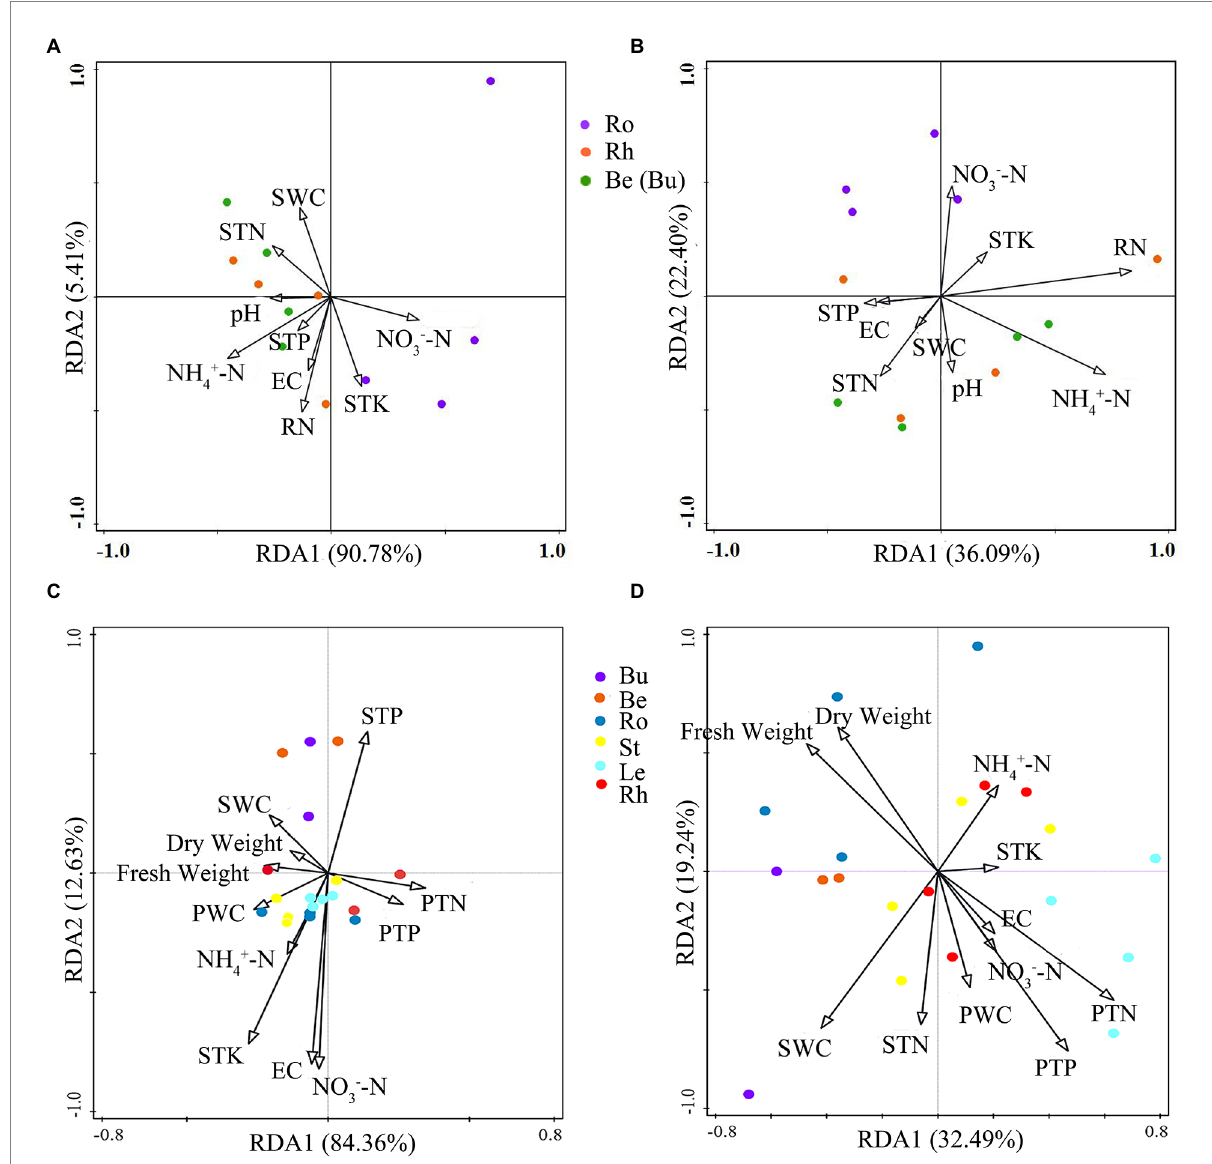
FIGURE 8 The RDA analysis plots showing the relationship between environmental factors and pine associated bacterial (A) and fungal (B) communties at the OTU level and the relationship between environmental factors and P.n.- associated bacterial (C) and fungal communties (D) at the OTU level. Soil traits: SWC, soil water content, STN, soil total nitrogen, STP, soil total phosphorous, STK, soil total potassium, NH 4+ -N, soil ammonium nitrogen, NO 3 − -N, soil nitrate nitrogen, EC, soil conductivity. Plant traits: RN, Root nitrogen, Dry weight, plant dry weight, Fresh weight, plant fresh weight, PWC, plant water content, PTP, plant total phosphorous, PTN, plant total